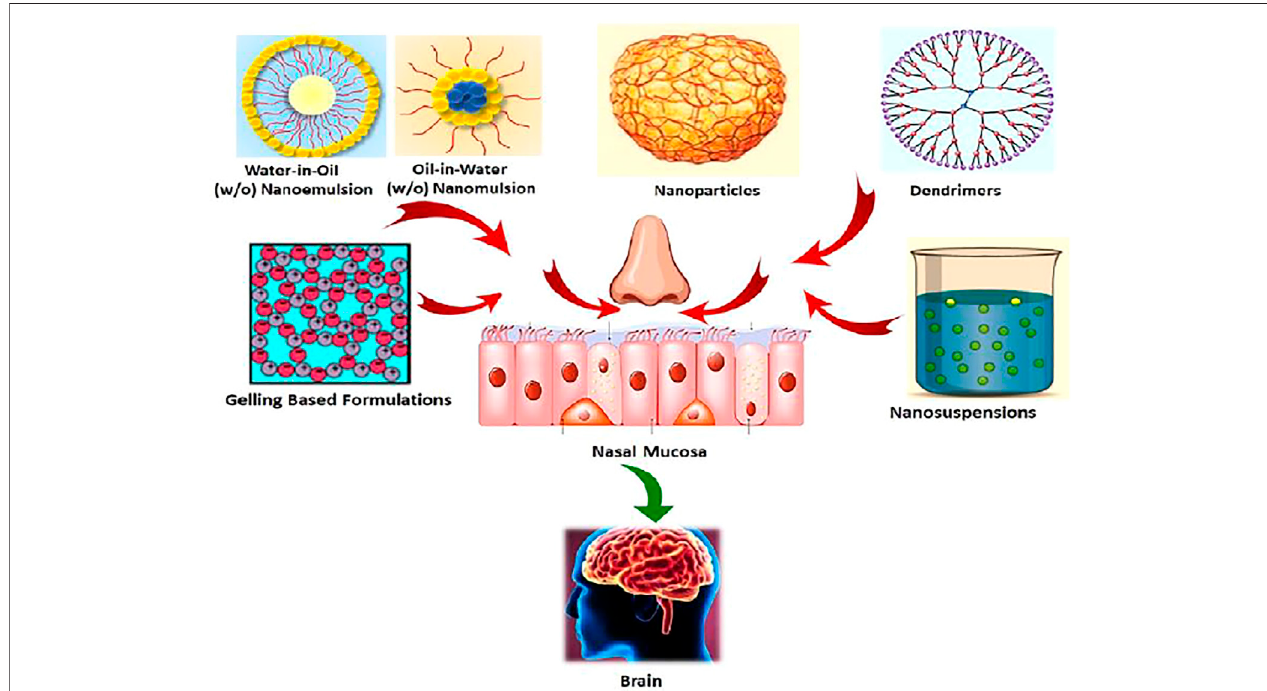
FIGURE 3 | Various advanced drug delivery tools for nose-to-brain targeting of neurotherapeutics.